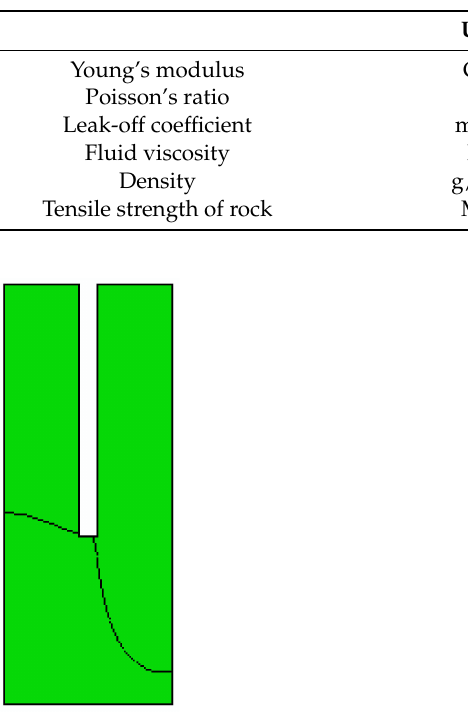
Table 1. Initial values of physical parameters.